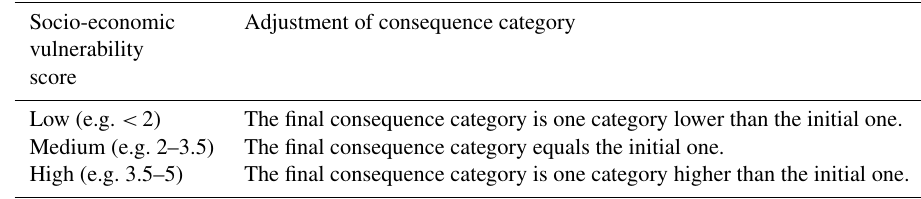
Table 7. Indicative criteria for determining the consequence category using vulnerability indicators and adaptation of initial categorisation to final categorisation.